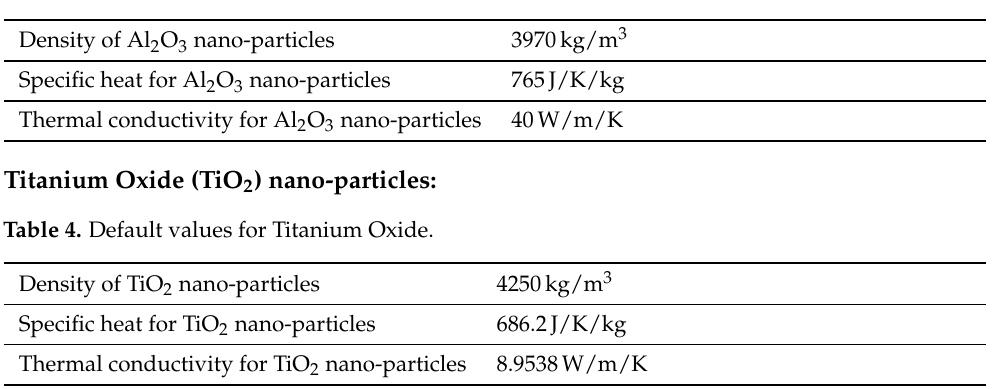
Table 3. Default values for Aluminium Oxide.